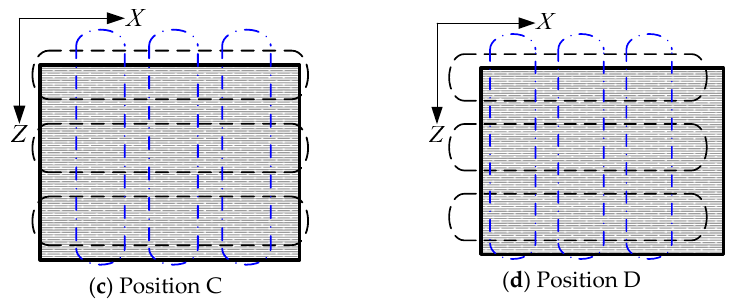
Figure 2. Positional relationship between mover and windings in different motion.